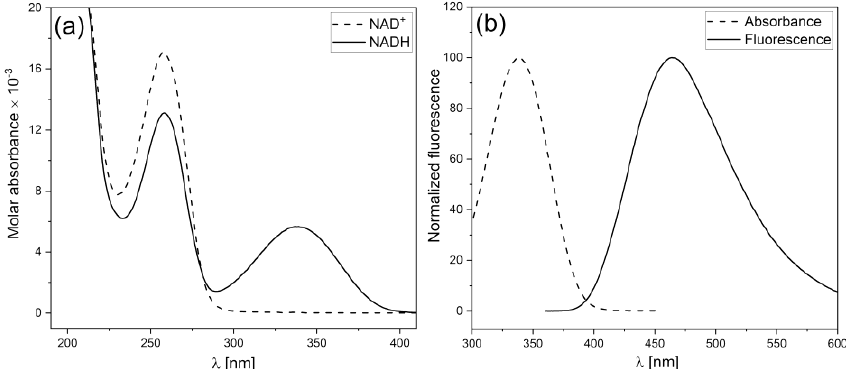
Figure 1. Electronic absorption spectra of NADH and NAD + ( a ) and fluorescence spectra of NADH ( b ) [14]. Reproduced from Katarzynska, J; Lipinski, Z.; Cholewinski, T., Piotrowski, L; Dworzynski, W.; Urbaniak, M.; Borkowska, A.; Cypryk, K.; Purgal, R.; Marcinek, A.; Gebicki J. Non-invasive evaluation of microcirculation and metabolic regulation using flow mediated skin fluorescence (FMSF): Technical aspects and methodology. Rev Sci Instrum. 2019 , 90 , 104104; DOI:10.1063/1.5092218, with the permission of AIP Publishing.